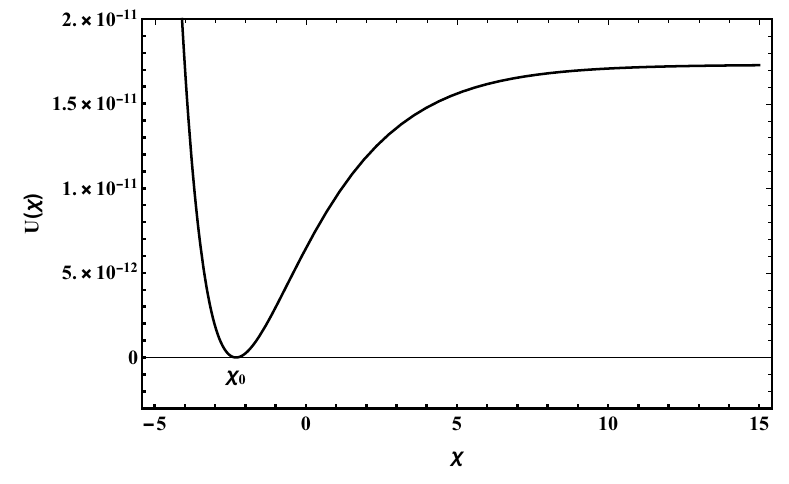
Figure 15 . The in(cid:13)ationary potential (A.3) obtained in the limit (cid:24) (cid:29)